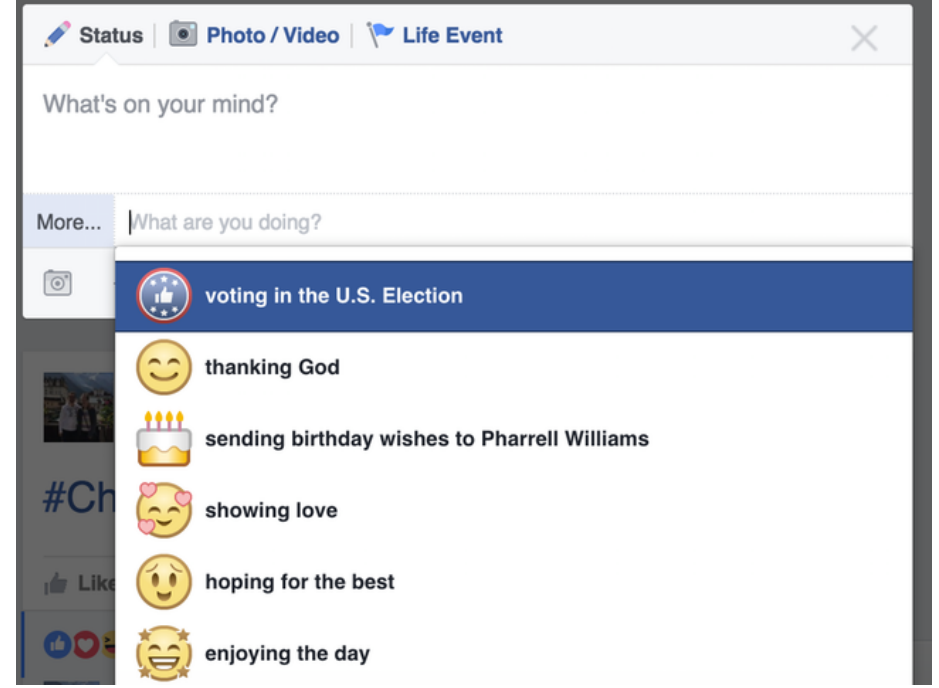
Figure 10: United States, 2016 (Grant, 2016) In the end, the extent of changes in the interface for each election, international variations in the tool, who saw election reminders and their effects, the data the company collected, and what will happen during future elections are all unknown. In addition to making it difficult to hold Facebook accountable, these transient affordances impact the political information environment in unknown and potentially deeply problematic ways, as we return to in the discussion